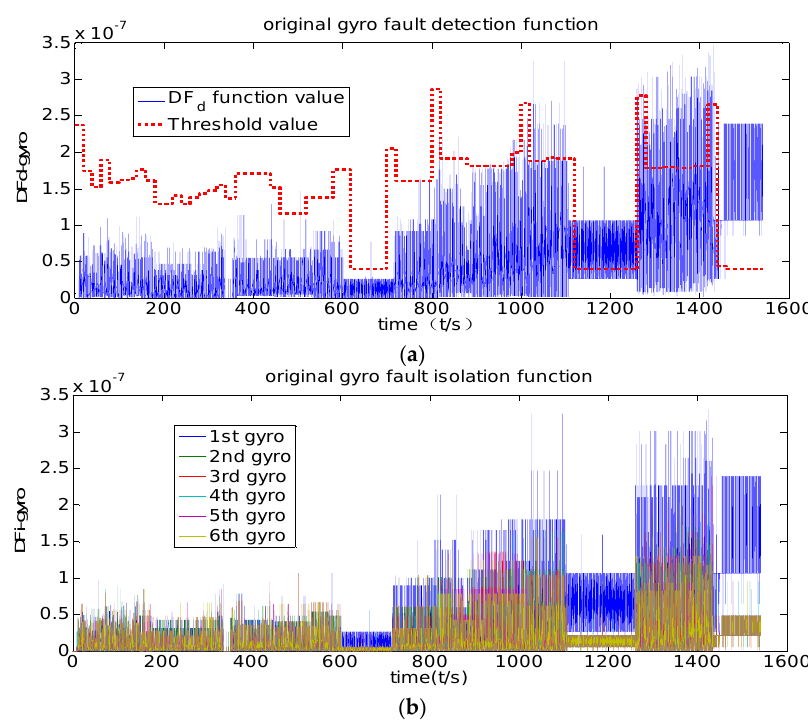
Figure 11. Original channel filter. ( a ) Fault detection; ( b ) Fault isolation.